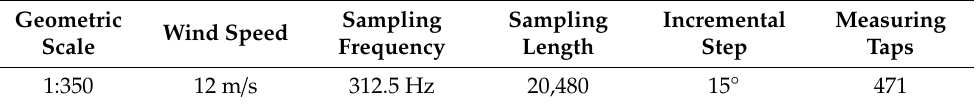
Table 2. Wind tunnel test parameters.